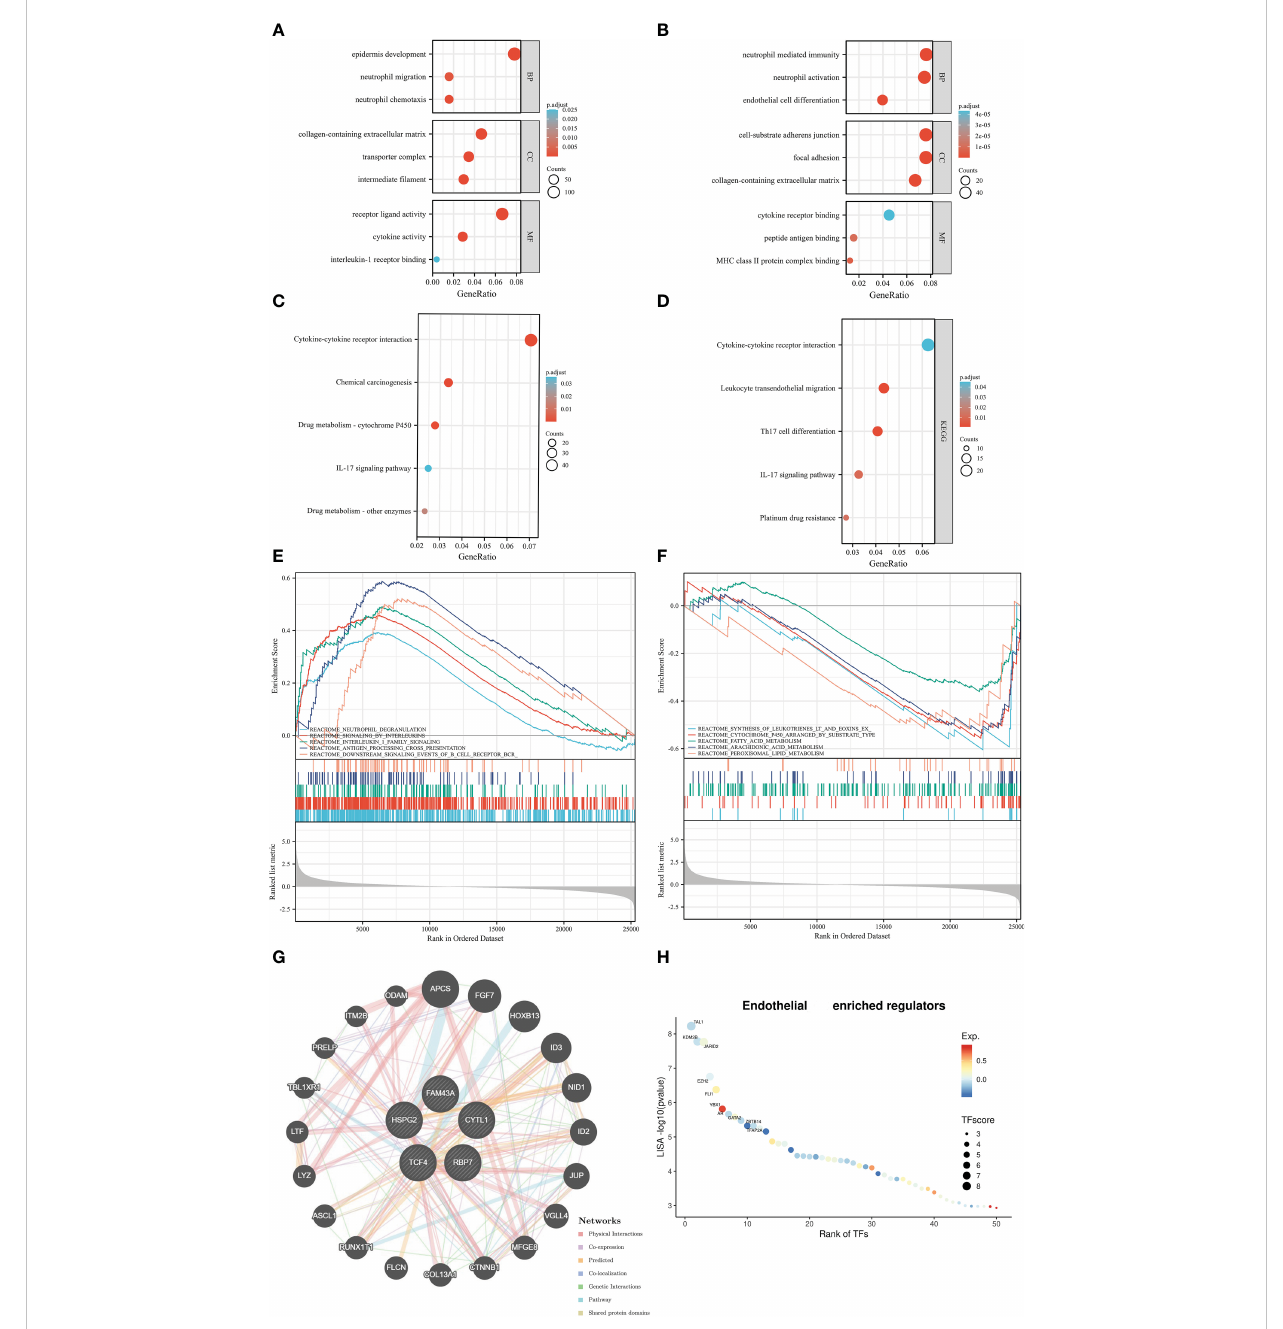
FIGURE 5 Function analysis: the Gene Ontology results based on the ERC (A) and endothelial cells (B) , Kyoto Encyclopedia of Genes and Genomes results based on the ERC (C) and endothelial cells (D) , Gene Set Enrichment Analysis results (E, F) , the protein – protein interaction network (G) , the interacting transcription factors of endothelial cells (H)